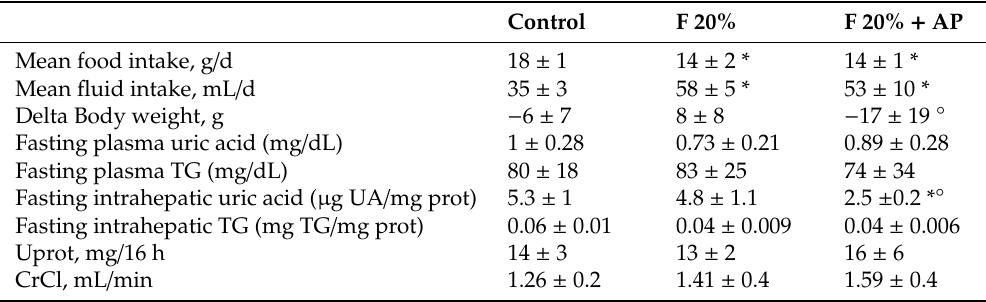
Table 1. General